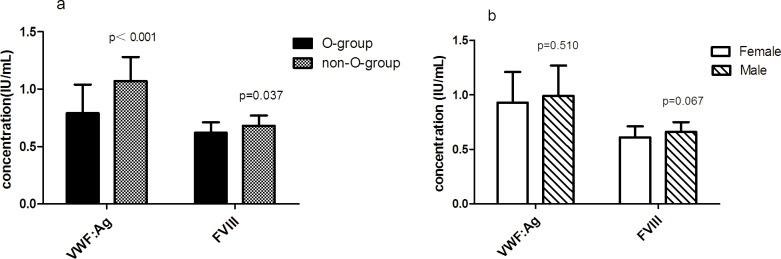
Levels of vWF: Ag and FVIII in HA blood donors with different genders and blood types.Values are mean ± SD. Non-O-group, n = 24; O-group, n = 17; Female, n = 18; male, n = 23.